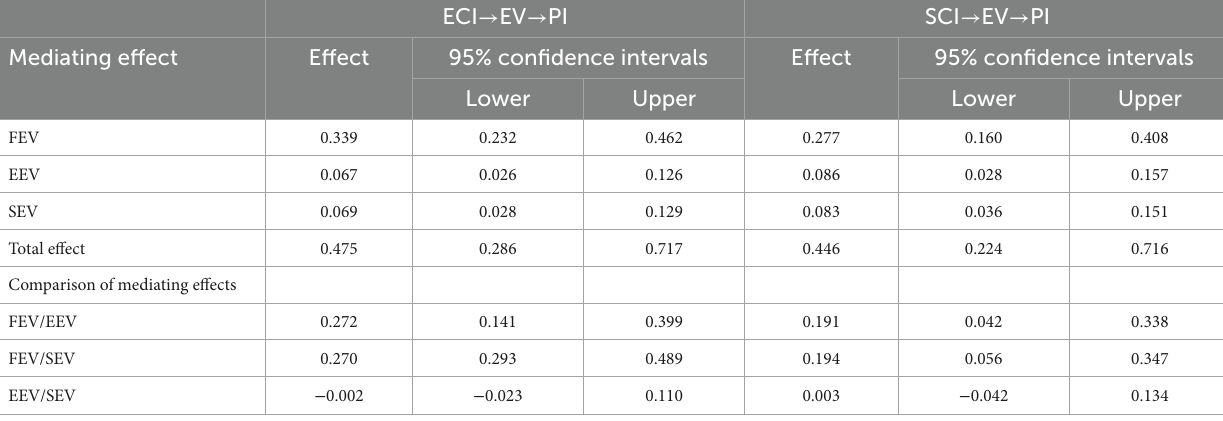
TABLE 6 Bootstrap analysis of the intermediate effects test.